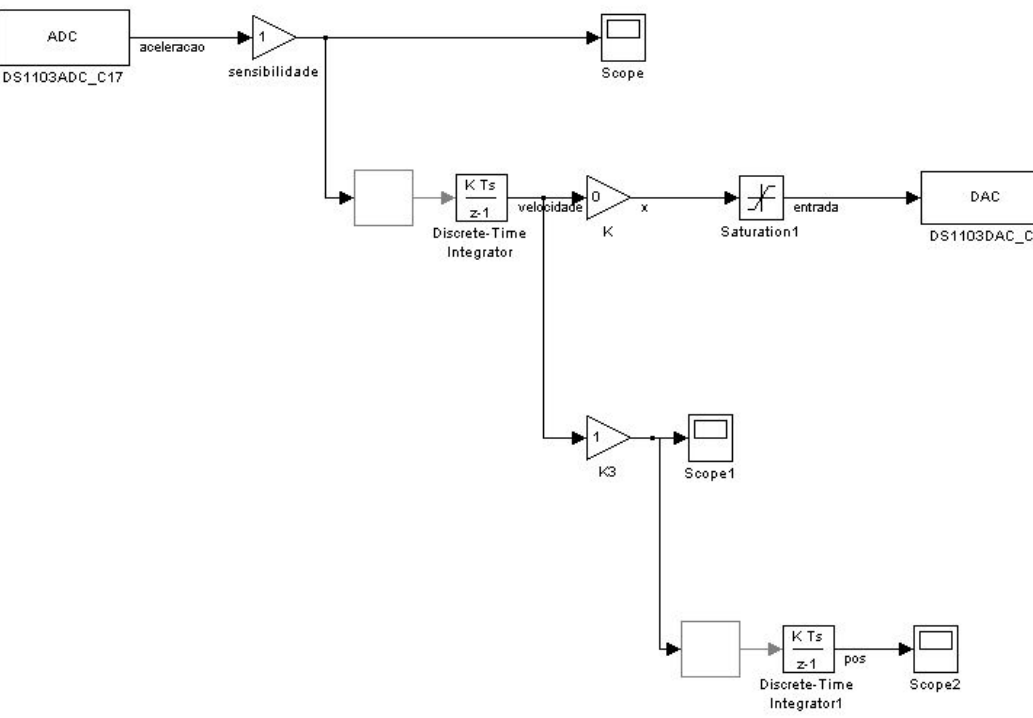
Figure 8. Simulink active control